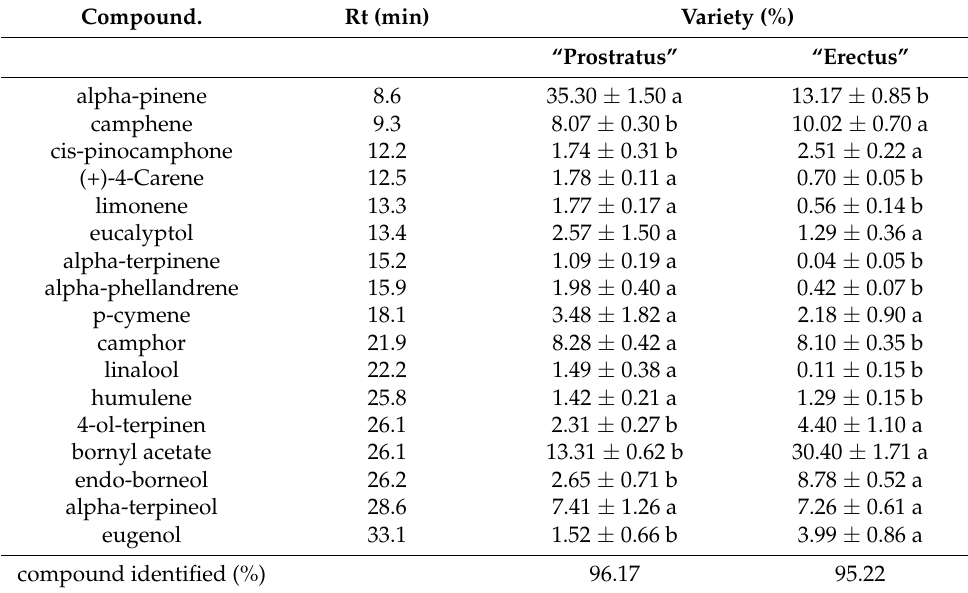
Table 2. Chemical composition of essential oils ( ≥ 1%) for the two rosemary varieties (mean ± stan- dard deviation) (n = 3). Letters (a, b) indicate statistically significant differences using the Tukey HSD post hoc test ( p <